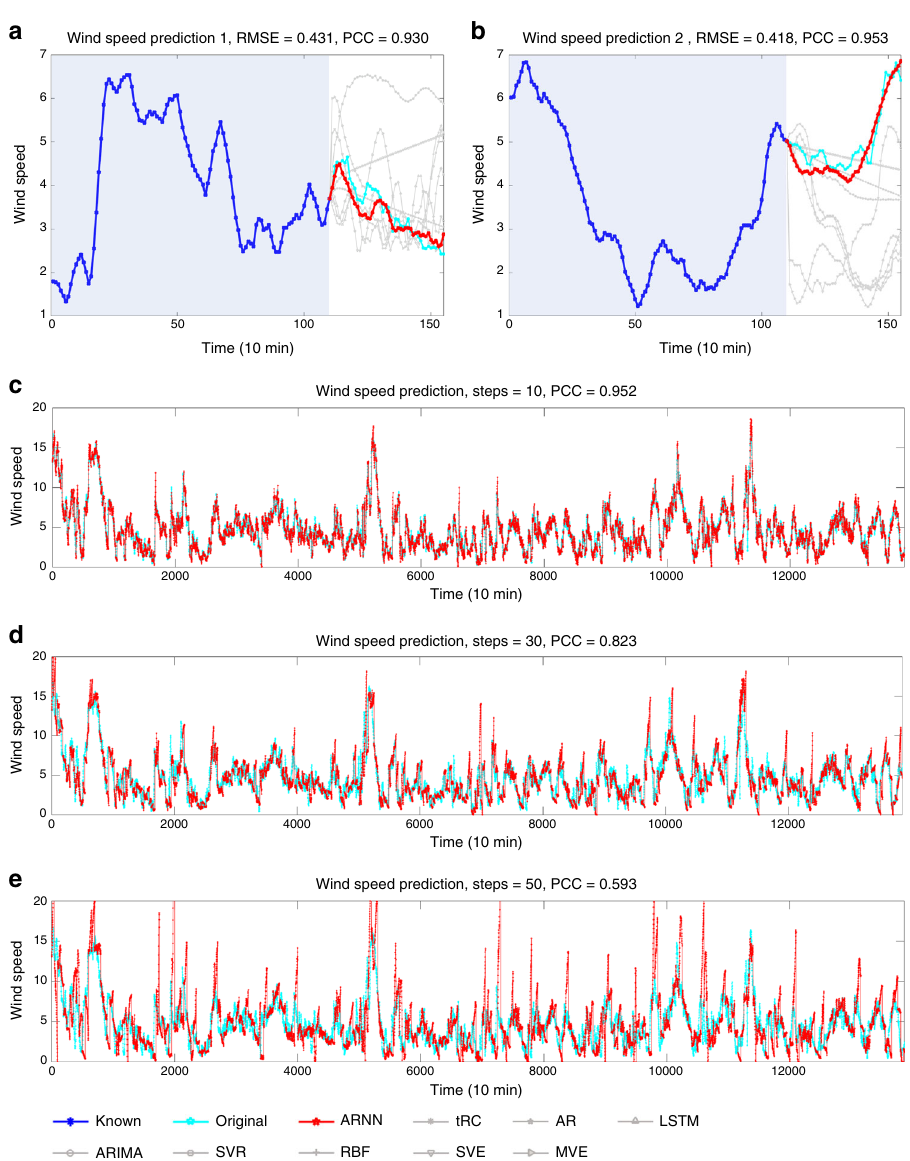
Fig. 3 Wind speed prediction in Wakkanai, Japan. Based on the time-course data of D = 155 sampling sites in Wakkanai, Japan, ARNN was applied to forecast the wind speed ( m = 110). The prediction performance of different methods is shown over two periods ( L − 1 = 45) in ( a , b ). The performance of ARNN is signi fi cantly better than that of the other methods. The Pearson correlation coef fi cients (PCCs) between the ARNN prediction result and the original curve are 0.930 ( a ) and 0.953 ( b ). To demonstrate the robustness of our proposed method, ARNN was applied to the whole time series (time point 1 – 13,860, interval 10 min, 96 days). The results are exhibited for different sets of prediction steps, that is, prediction steps L − 1 = 10 ( c ), L − 1 = 30 ( d ), and L − 1 = 50 ( e ). Clearly, given the fi xed known length, predicting a shorter span is more accurate. Overall, the performance of ARNN with different prediction steps is robust and satisfactory for the whole period of 138,600